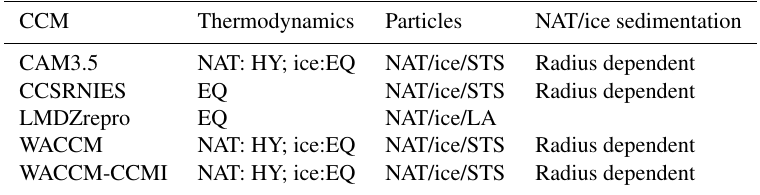
Table 4. Main features of simulation and of the microphysics of polar stratospheric clouds. EQ denotes thermodynamic equilibrium with gaseous HNO 3 / H 2 SO 4 / H 2 O assumed. HY denotes non-equilibrium/hysteresis considered. LA denotes liquid aerosol (adapted from CCMVal-2 report,